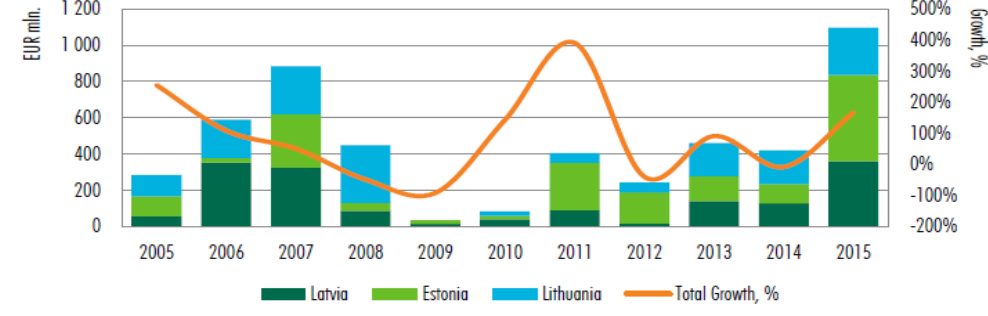
Fig. 2. Investment volumes by sectors per country, 2015 (CBRE, 2016, p.